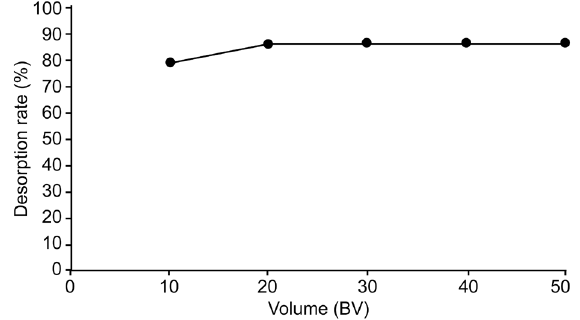
Figure 7: Desorption rate at different eluent volumes.